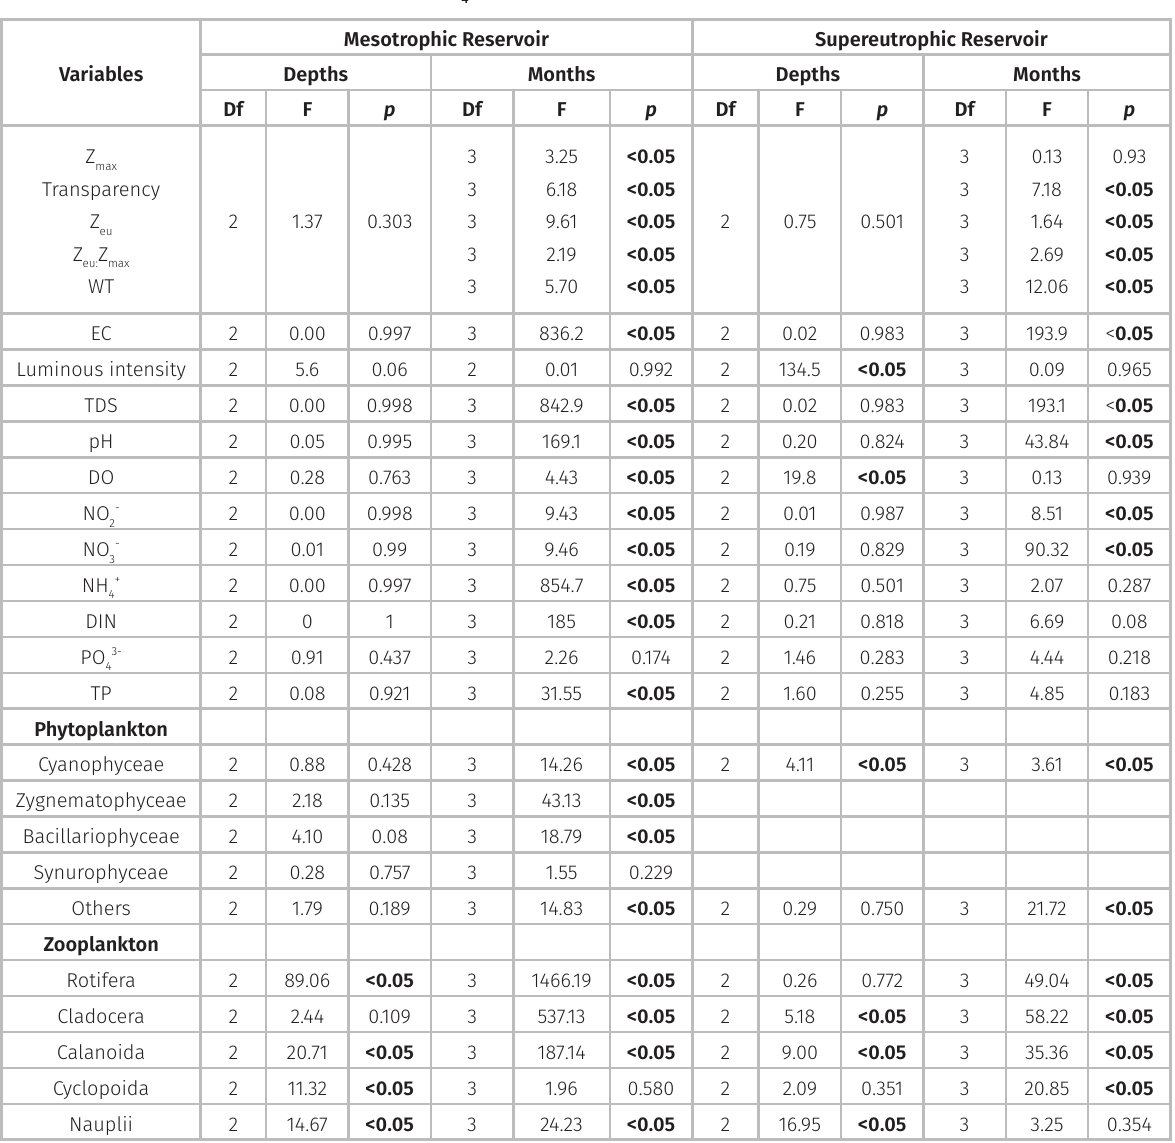
Table II. Statistical values of ANOVA two-way of limnological variables and zooplankton biomass (μg PS m -3 ) and and bottom) and the months studied (July, phytoplanktonic classes (mg L -1 ) between the depths (surface, Z eu September, January and March) in the mesotrophic (Tabocas) and supereutrophic (Tapacurá) reservoirs. Numbers in bold represent significant values ( p < 0.05). Z = Maximum depth (m); Transparency = Water transparency (cm); max = Depth of euphotic zone; Z :Z = Ratio between euphotic zone:maximum depth; WT = Water temperature (°C); Z eu eu max EC = Electrical conductivity (µS cm -1 ); Luminous intensity (µmol photons m -2 s -1 ); TDS = Total dissolved solids (mg L -1 ); DO = Dissolved oxygen (mg L -1 ); NO 2- = Nitrite (µg L -1 ); NO 3- = Nitrate (µg L -1 ); NH 4+ = Ammoniacal nitrogen (µg L -1 ); DIN = Dissolved inorganic nitrogen (µg L -1 ); PO 43- = Orthophosphate (µg L -1 ); TP = Total phosphorus (µg L -1 ).